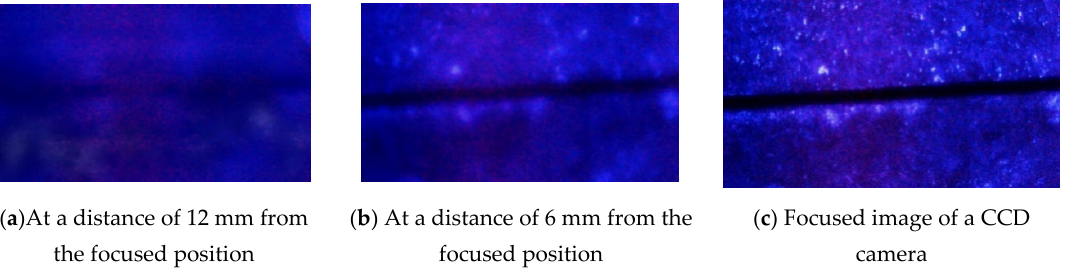
Figure 9. Images captured from a CCD camera during autofocus.